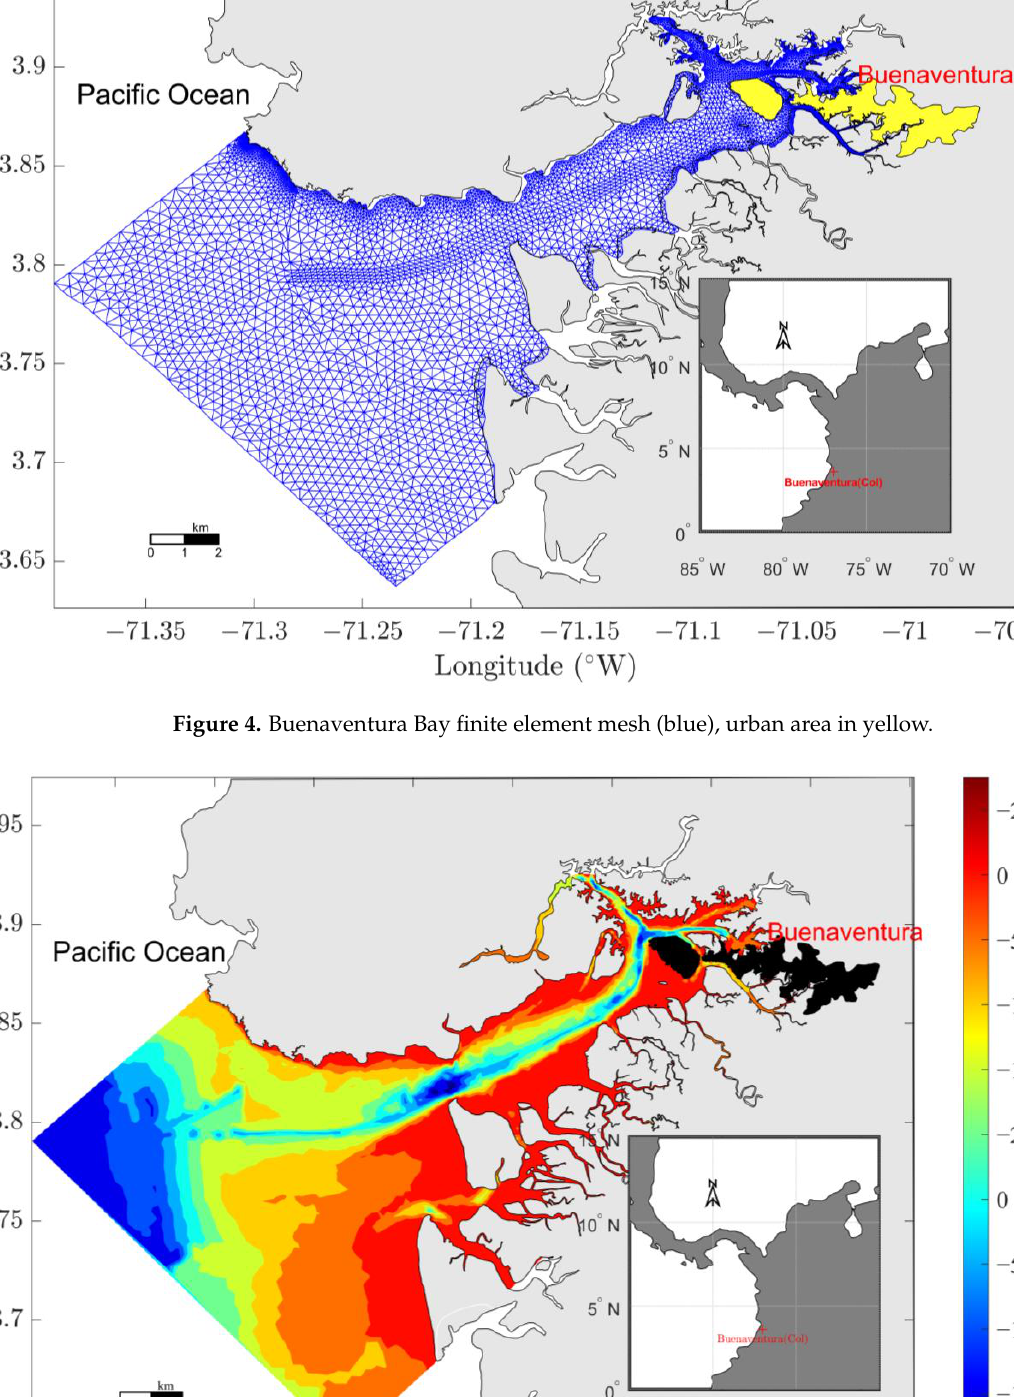
[17] and Fosati et al. [18]. The finite element mesh was discretized into five layers in the vertical direction.